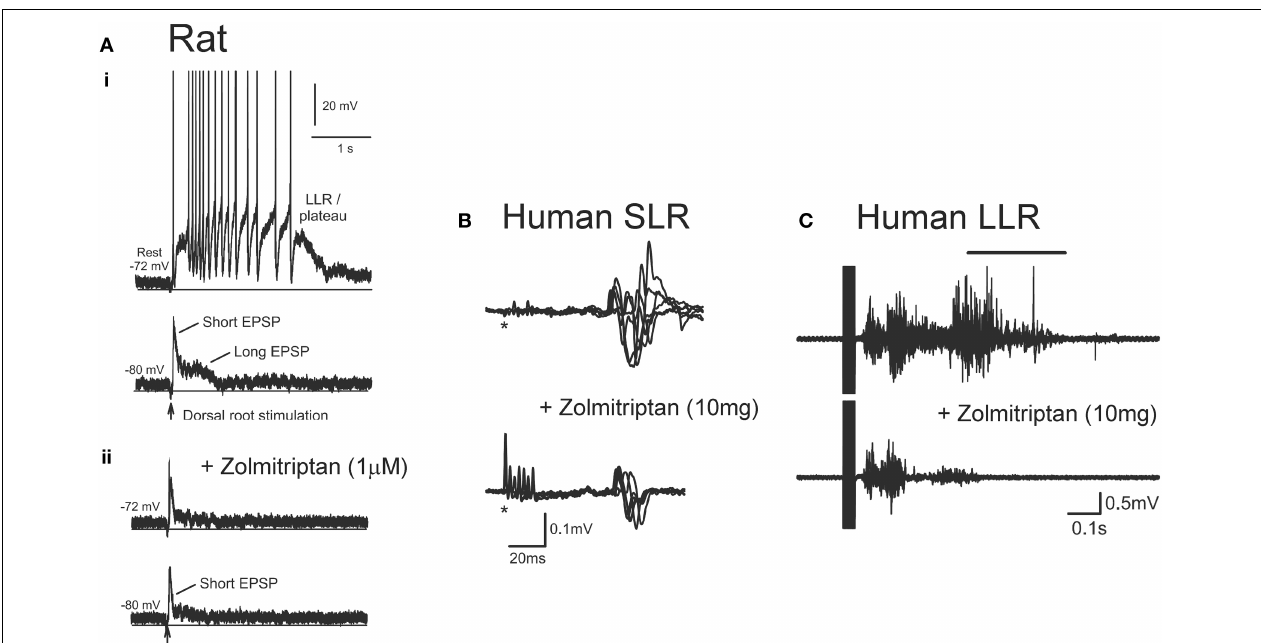
FIGURE 11 | Effect of zolmitriptan on sensory transmission in SCI rat and human. (A) Effects of zolmitriptan in chronically injured rat motoneurons. (i) Top trace : Intracellular recording from chronic spinal rat motoneuron at rest ( − 72mV) where single-pulse dorsal root stimulation produces PIC-mediated long-lasting reflex (LLR). Bottom trace : same motoneuron hyperpolarized to − 80mV to reveal short and long EPSP in response to dorsal root stimulation. (ii) Recording from same motoneuron in (i) at rest (top trace) and during hyperpolarization (bottom trace) after application of the 5HT 1B / D receptor agonist zolmitriptan. Note elimination of the long-duration EPSP which